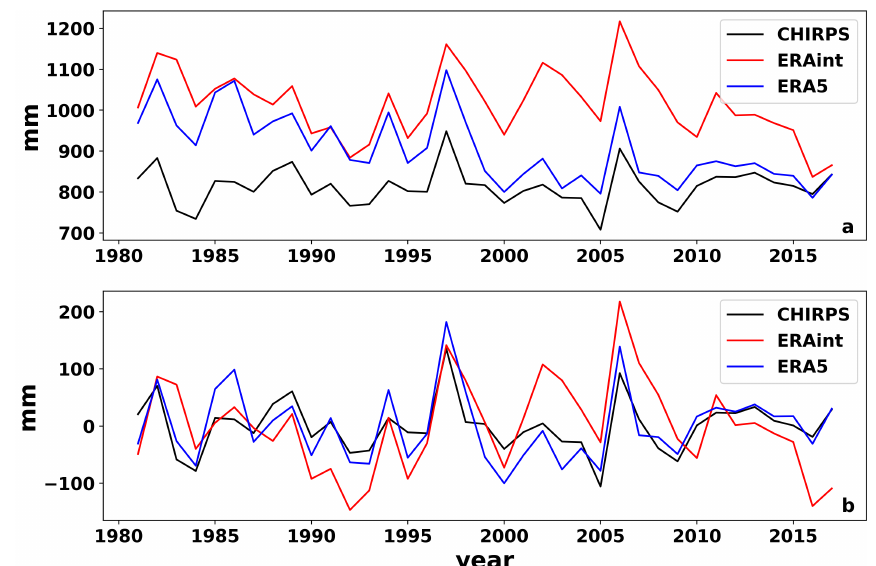
Figure 10. Annual precipitation averaged over longitude band 25 ◦ E–50 ◦ E and 13 ◦ S–17 ◦ N (East Africa box) in observations (CHIRPS, black), ERA-interim (red), and ERA5 (blue) from 1981 to 2017 as annual sums ( a ) and detrended annual anomalies ( b